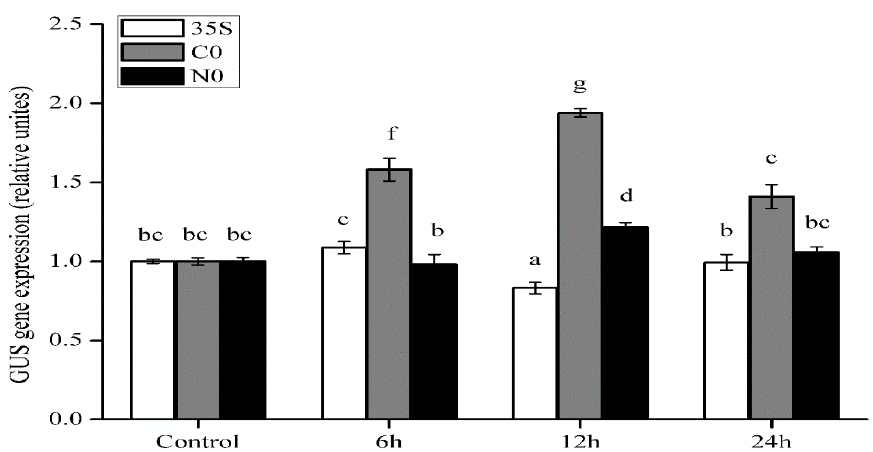
Figure 5. qRT-PCR analysis of GUS gene expression driven by full-length promoter constructs under salicylic acid treatment. Fourteen-day-old Arabidopsis seedlings were exposed to 100 µ M SA for 6, 12, or 24 h. Seedlings were used for RNA extraction and qRT–PCR analysis. Data represent the mean ± SD of three independent transgenic lines, each measured with three technical replicates. Different letters indicate significant differences ( p < 0.05) according to one-way ANOVA followed by Duncan’s test ( n =